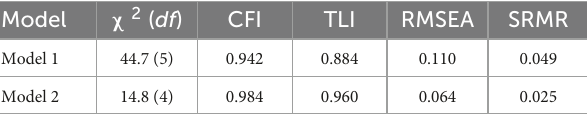
TABLE 2 Goodness-of-fit indices for the models evaluated of CRSB. TABLE 3 Standardized factor loadings of the confirmatory factor analysis for the final